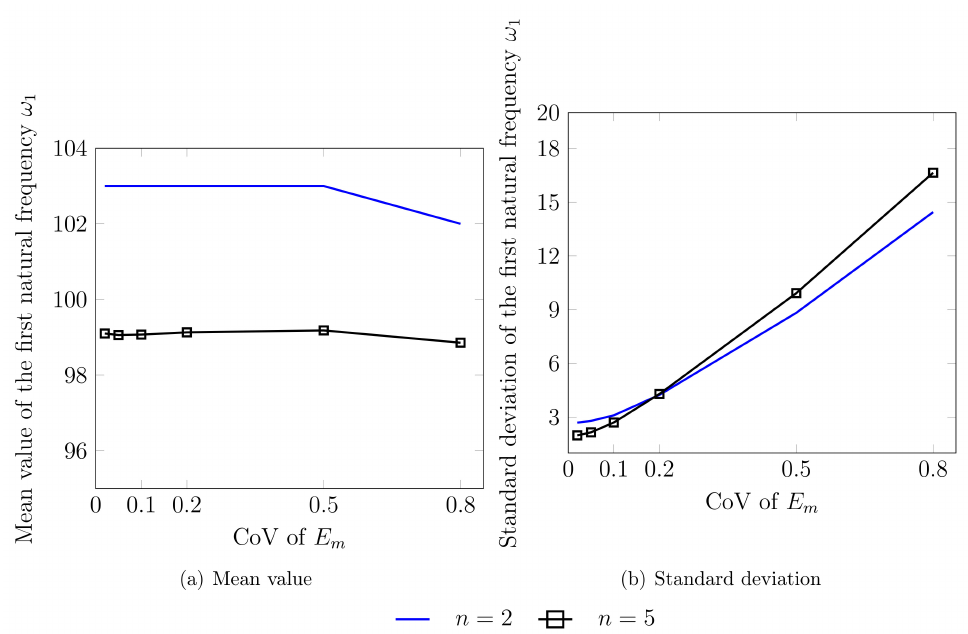
Figure 10. ( a ) Mean and ( b ) standard deviation of the first natural frequency ω 1 , for the variation of CoV of the metal, considering the gradient index n = 2 and